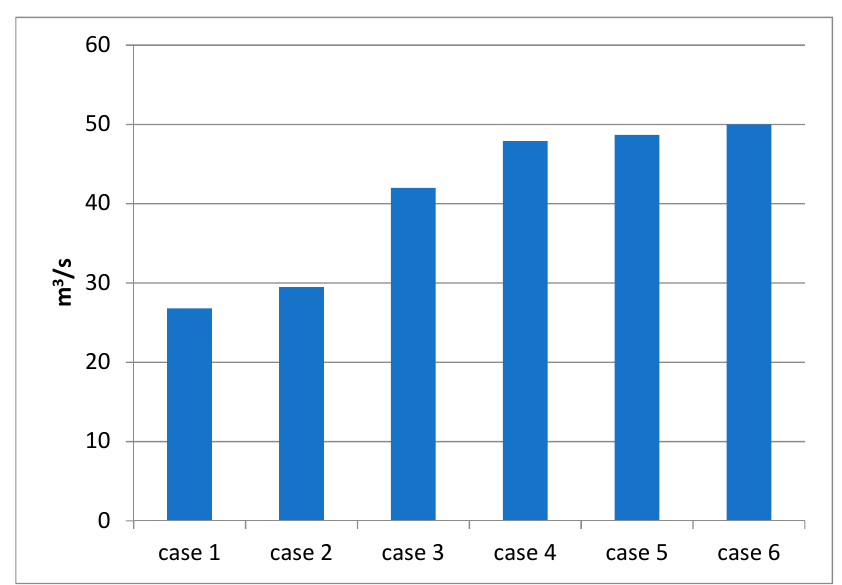
Figure 11. Total volume flow rate (m 3 /s).